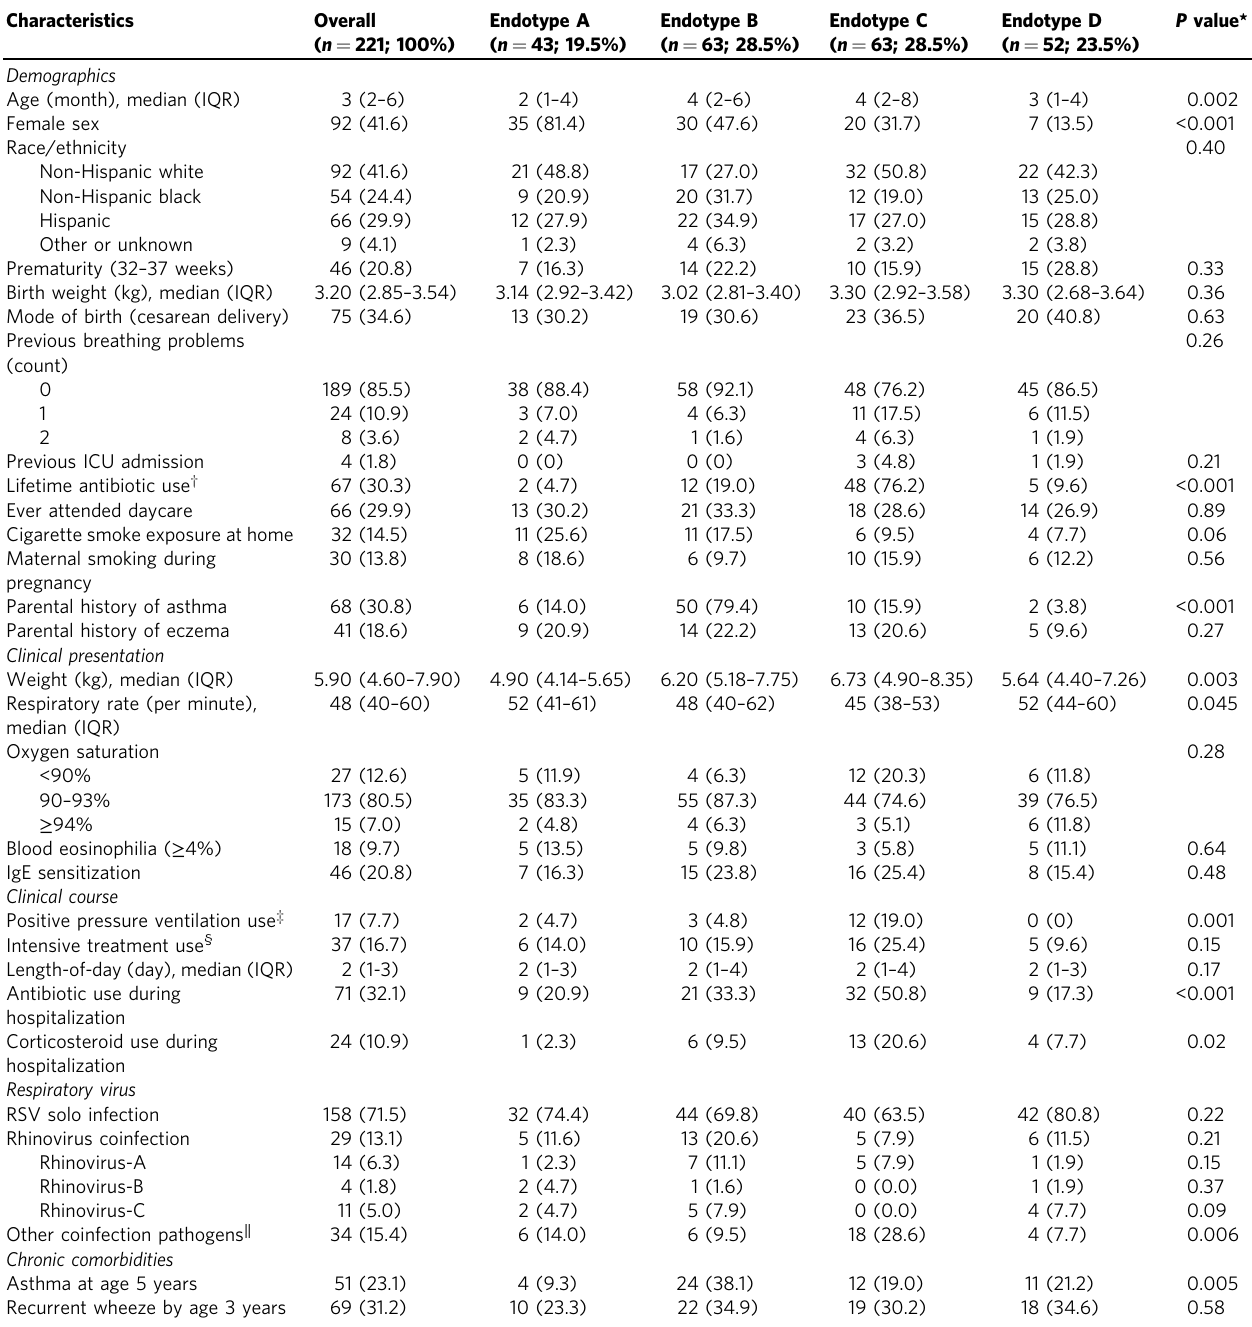
Table 1 Baseline characteristics and clinical course of infants, according to respiratory syncytial virus bronchiolitis endotypes.